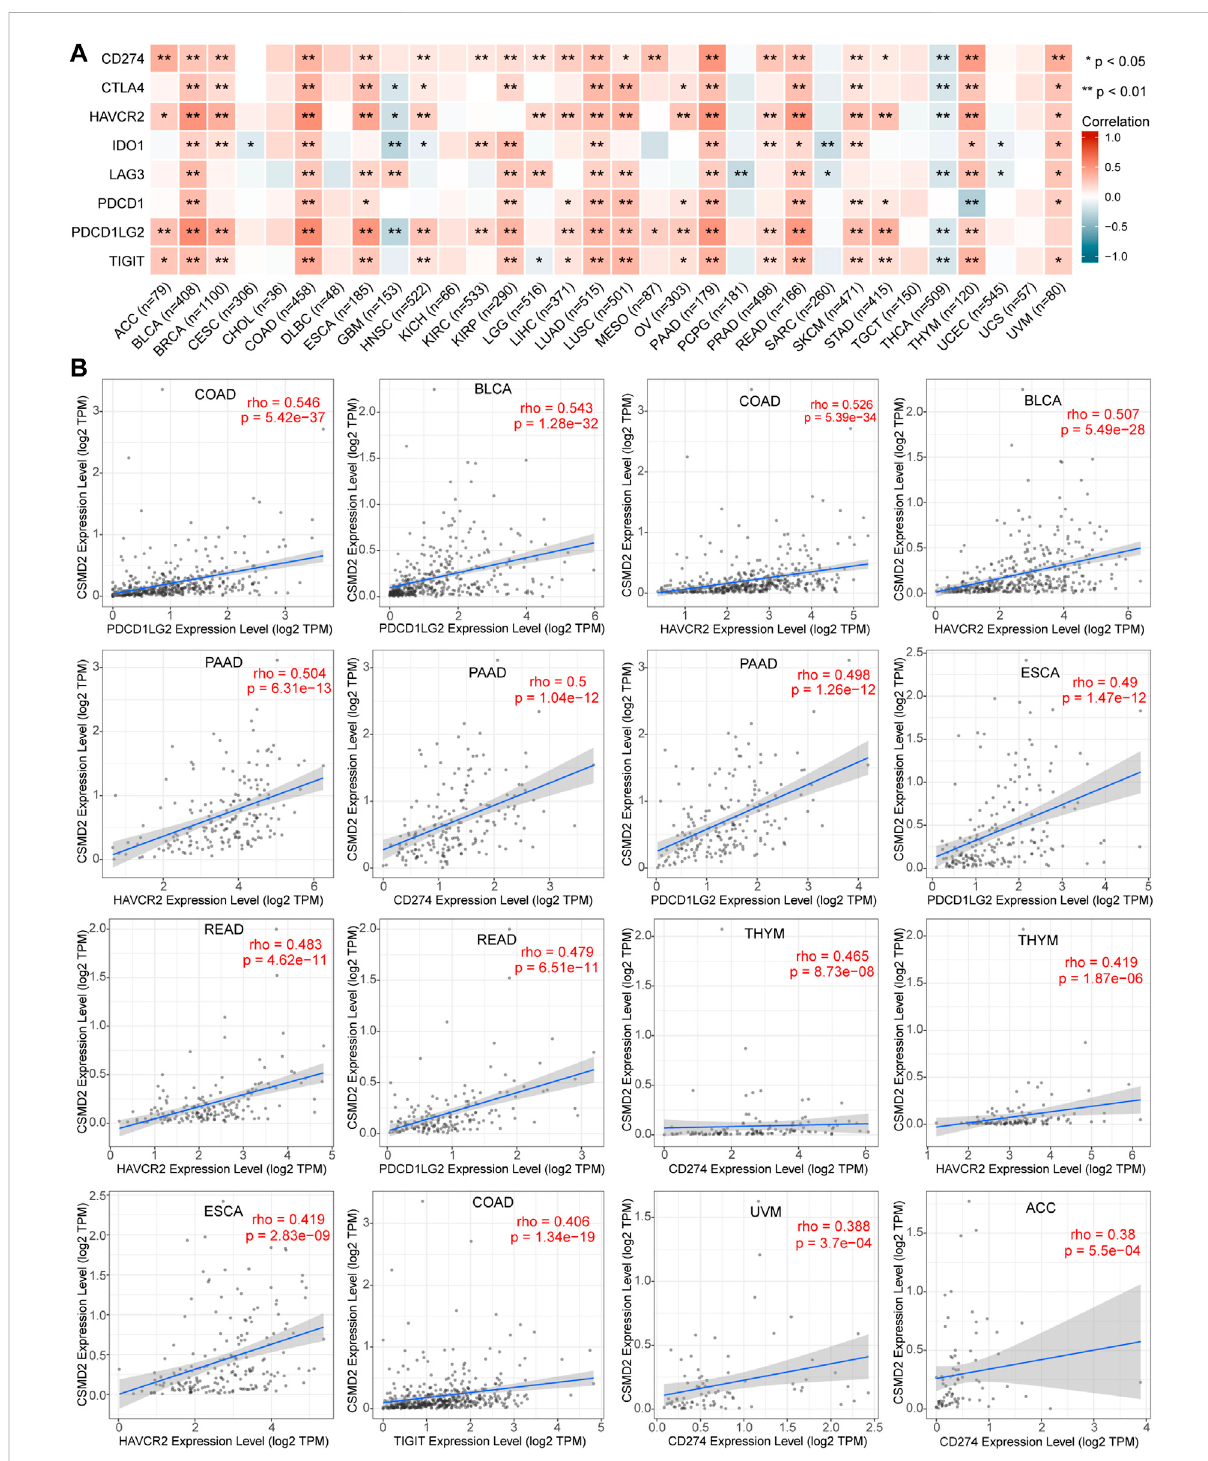
FIGURE 8 Correlation analyses of the CSMD2 expression with immune checkpoints. (A) Heat maps display a correlation between CSMD2 expression and immune checkpoints, including TIGIT, CD274, PDCD1, LAG3, HAVCR2, CTLA4, IDO1, and PDCD1LG2 in pan-cancer. (B) The top sixteen strongest correlations are displayed via scatter plots. Correlations are depicted with Spearman ’ s correlation and statistical signi fi cance based on TIMER